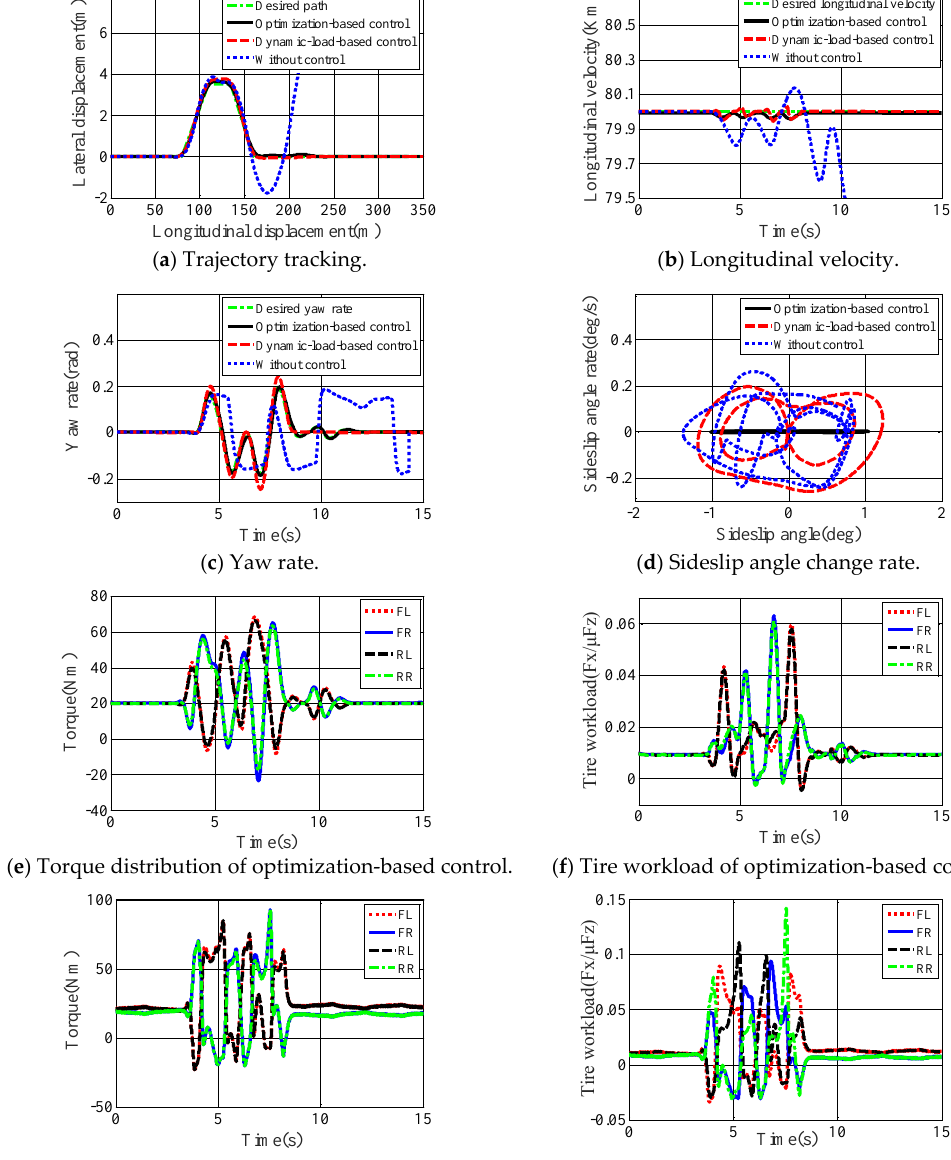
Figure 8. Simulation results for double lane change with high friction.